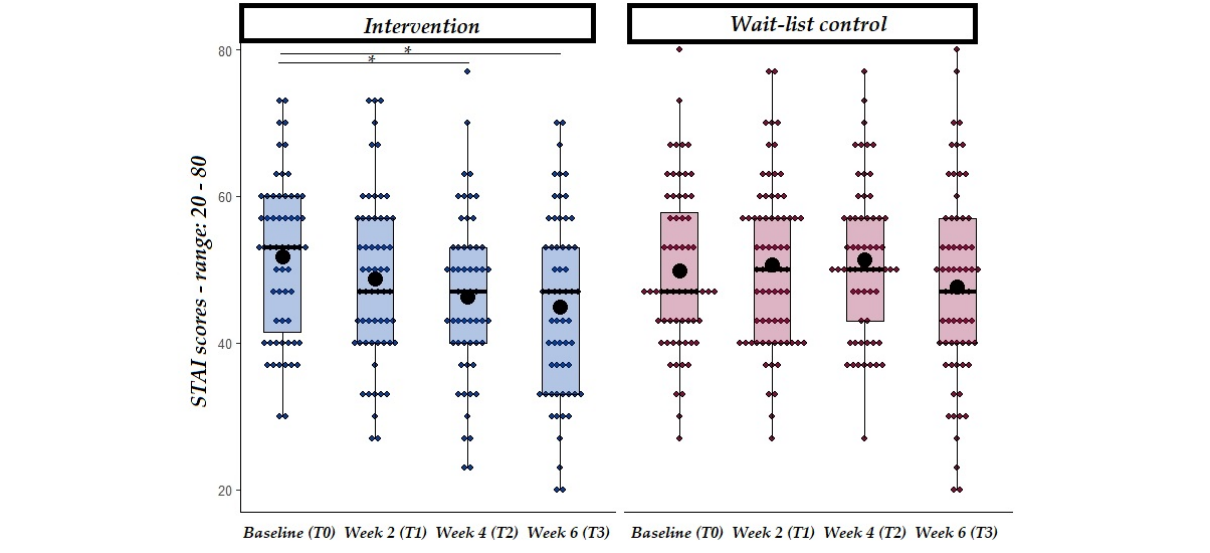
Figure 3. STAI scores at baseline, week 2, week 4 and week 6 follow-up from the start of the intervention in both intervention and wait-list control groups. Solid line=median; black dot=mean; whiskers: upper whisker=min(max(x), Q_3 + 1.5 x IQR); lower whisker=max(min(x), Q_1 - 1.5 x IQR). * P